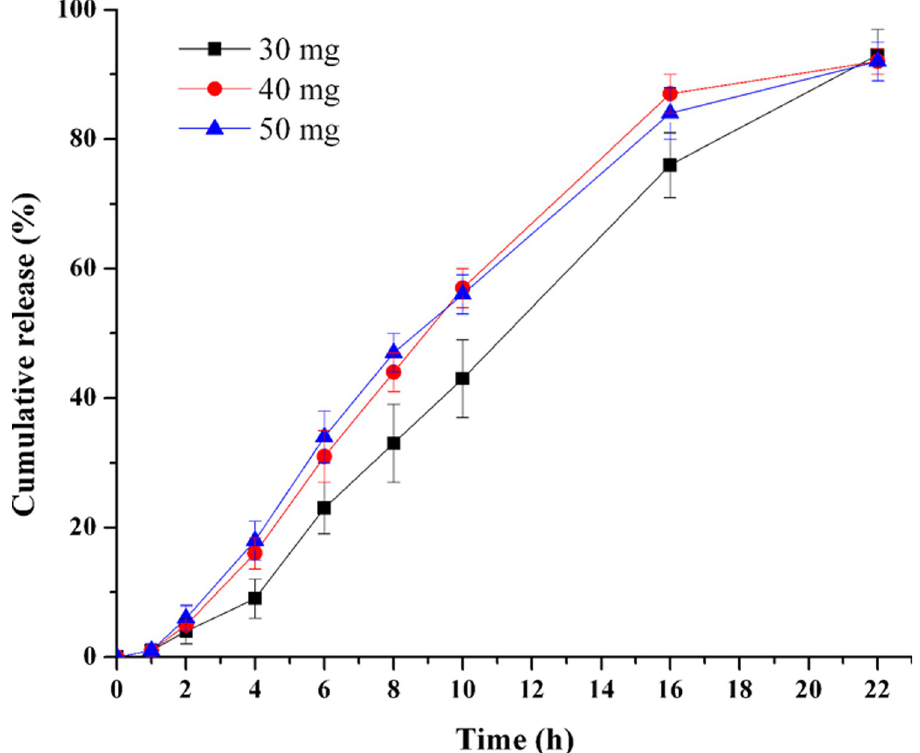
Fig 4. Effect of NaCl amount in the drug layer on TPM release (n =